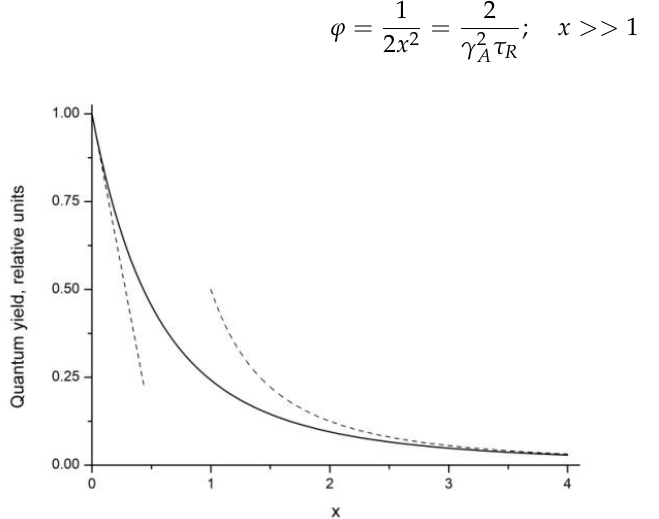
 √ Figure 1. Fluorescence relative quantum yield of the static quenching Equation (6) as a function τ R /2. Dashed lines are calculated using approximate Formulas (8) and the argument x = γ A x   = / 2 AR of the argument . Dashed lines are calculated using approximate Formulas (8) and (9).